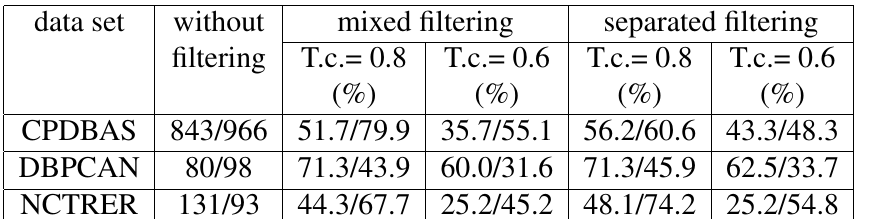
Table 1: Data set characterization in terms of the number of toxic and non-toxic molecules, with and without filtering. N1/N2 in each cell represents N1 toxic molecules and N2 non-toxic molecules. T.c. stands for the Tanimoto